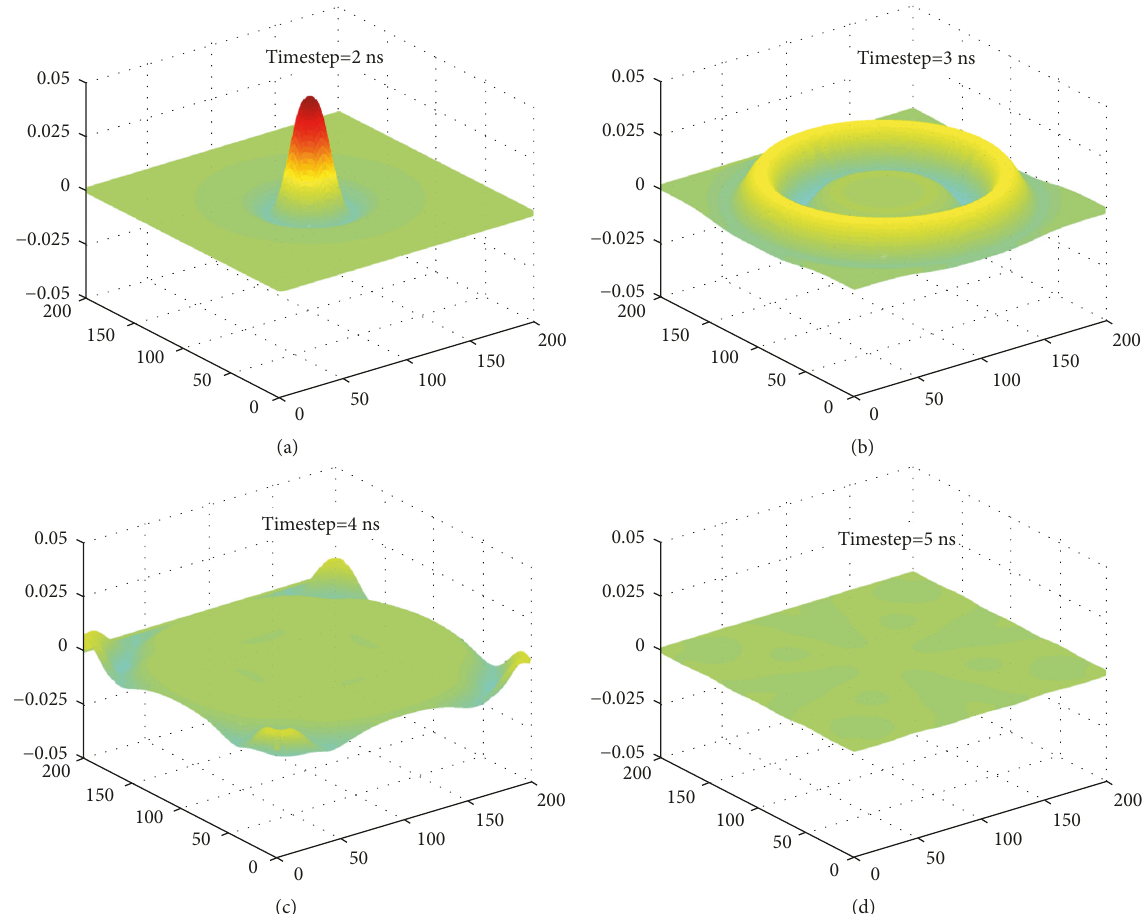
Figure 7: Distribution of field component 𝑈 at different time steps. (a) Snapshots of the 𝑈 at 2 ns time step. (b) Snapshots of the 𝑈 at 3 ns time step. (b) Snapshots of the 𝑈 at 4 ns time step. (d) Snapshots of the 𝑈 at 5 ns time step. n +1 third updates 𝐴 . And T is time step; T Max is total time